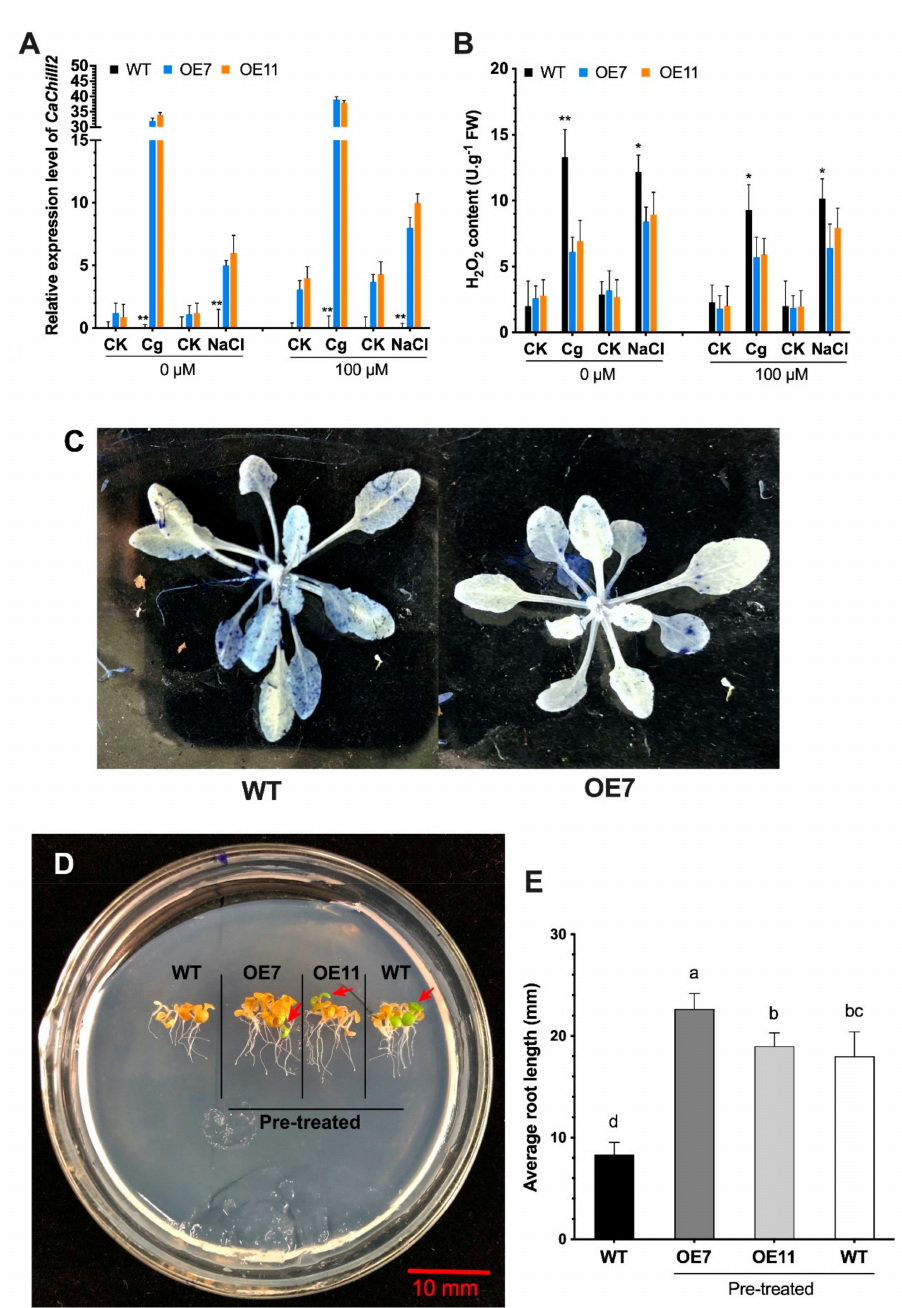
Figure 9. The effect of CaChiIII2 -overexpression and melatonin treatment on Arabidopsis stress tolerance. ( A ) The expression level of CaChiIII2 in Cg ( C. gloeosporioides ) infected, NaCl treated and CK (control) pants, one group was pretreated with 0 µ M and another with 100 µ M melatonin, ( B ) H 2 O 2 concentrations in WT and transgenic lines, ( C ) Nitro-blue tetrazolium chloride (NBT) staining showing • O 2 − concentrations in WT and CaChiIII2 -overexpressed lines, ( D ) The phenotypes showed root length of unprimed (WT) and melatonin primed Arabidopsis WT and transgenic lines growing on MS medium supplemented with 300 mM/L NaCl, ( E ) Graphical presentation of root length (mm). Mean values ± SDs of five replications are provided. Asterisks and lower-case letters (a–d) on the bars denote differences among means at p ≤ 0.05 (*) and p ≤ 0.01 (**) according to the DMR